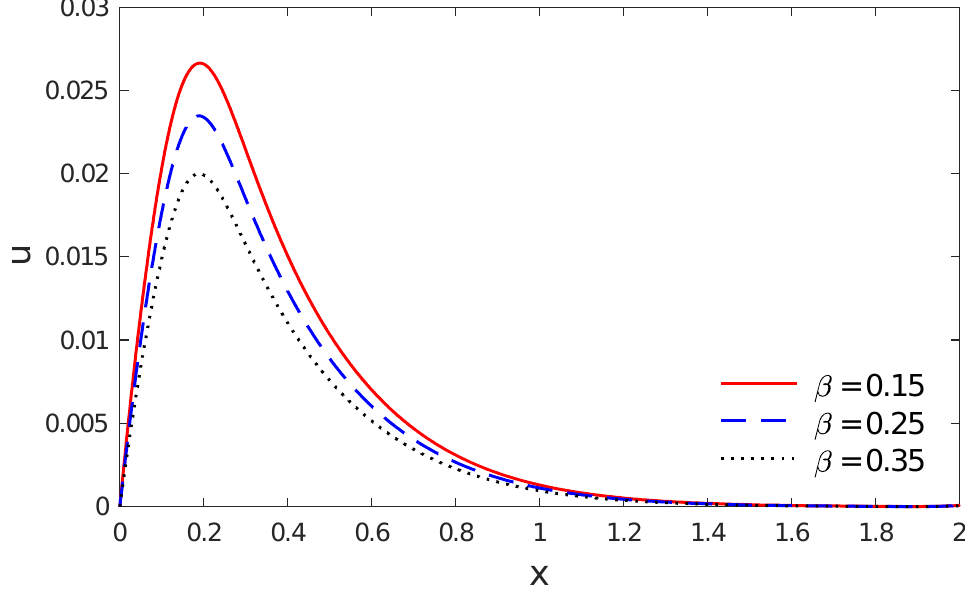
Figure 4 : The variations of solid displacement 𝑢 with respect to the distance 𝑥 for several values of porosity.